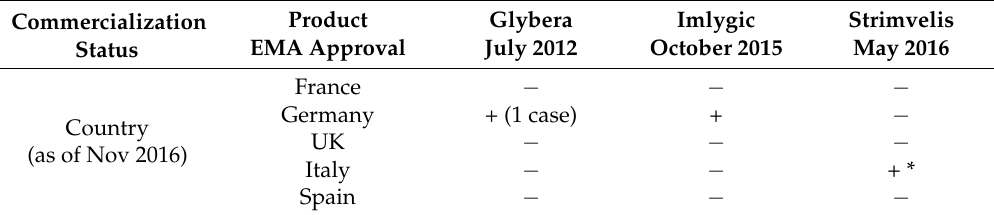
Table 1. Commercialization status of gene therapies in key European